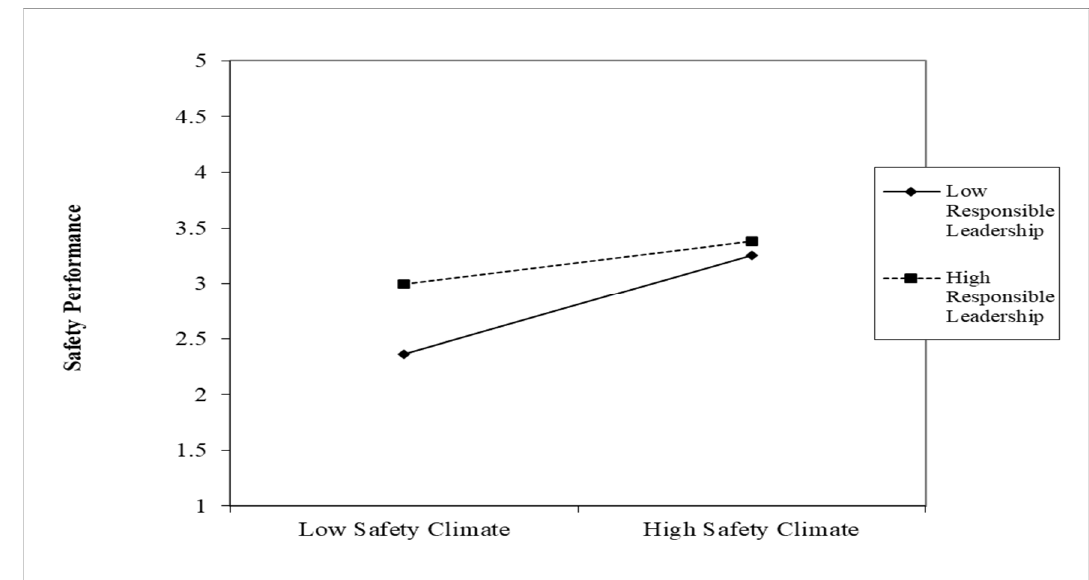
Figure 3. Interaction plot for responsible leadership and safety climate.